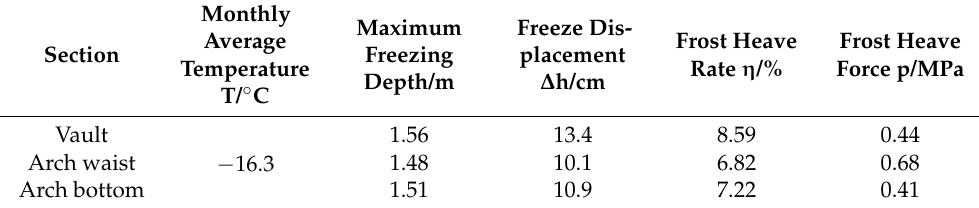
Table 2. Measured values of frost heave in the hydraulic